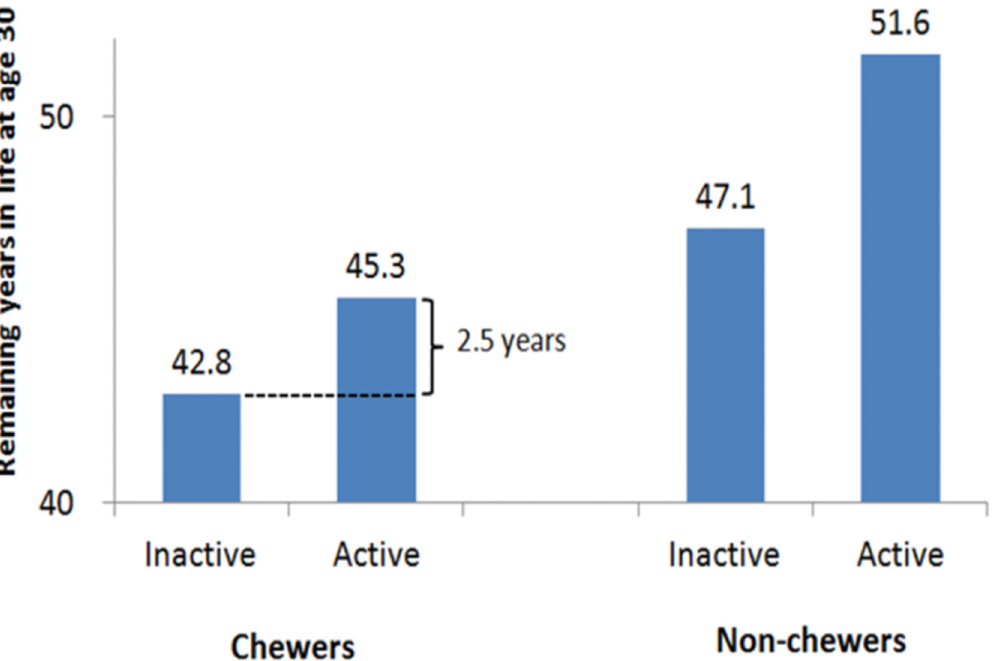
Fig 2. Differences in remaining years in life by chewing status and by physical activity status (males at age 30).